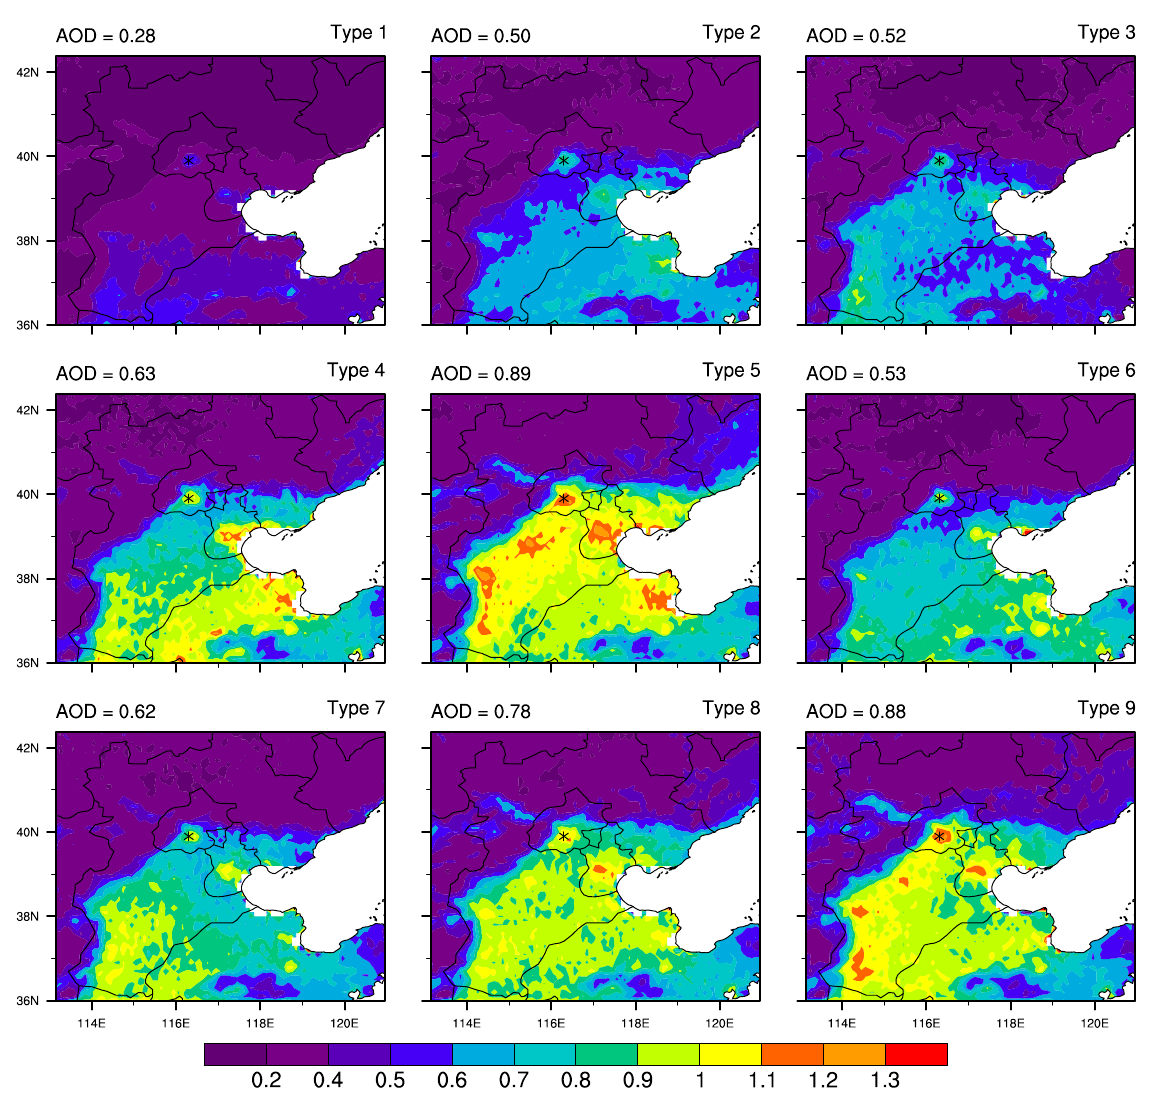
Fig. 8. Averaged 10-km AOD (MODIS 550nm) maps for each circulation type from February 2000 to December 2009 (the upper left number denotes the area mean over